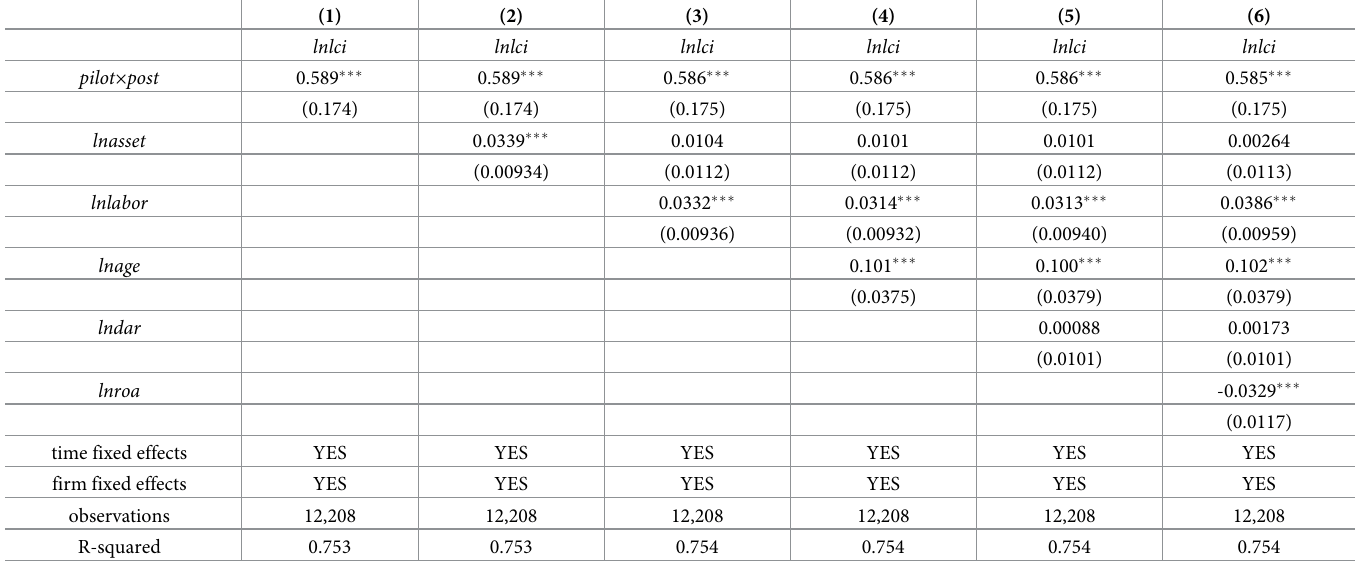
Table 2. Baseline regression